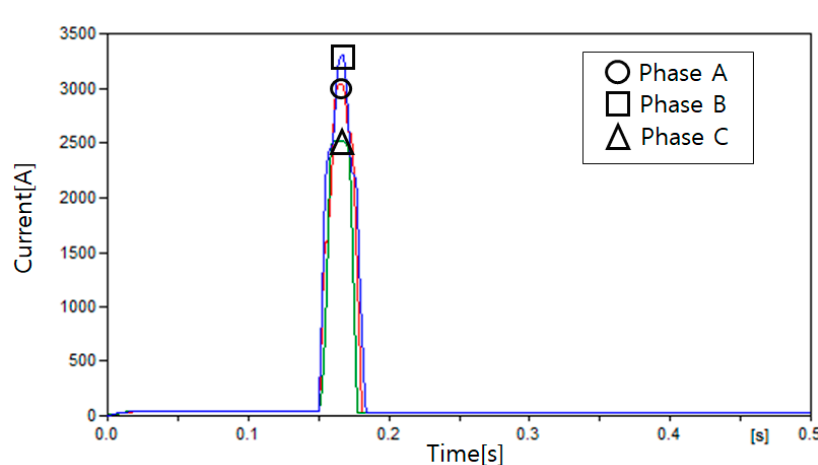
Figure 28. Fault location in Case 8.